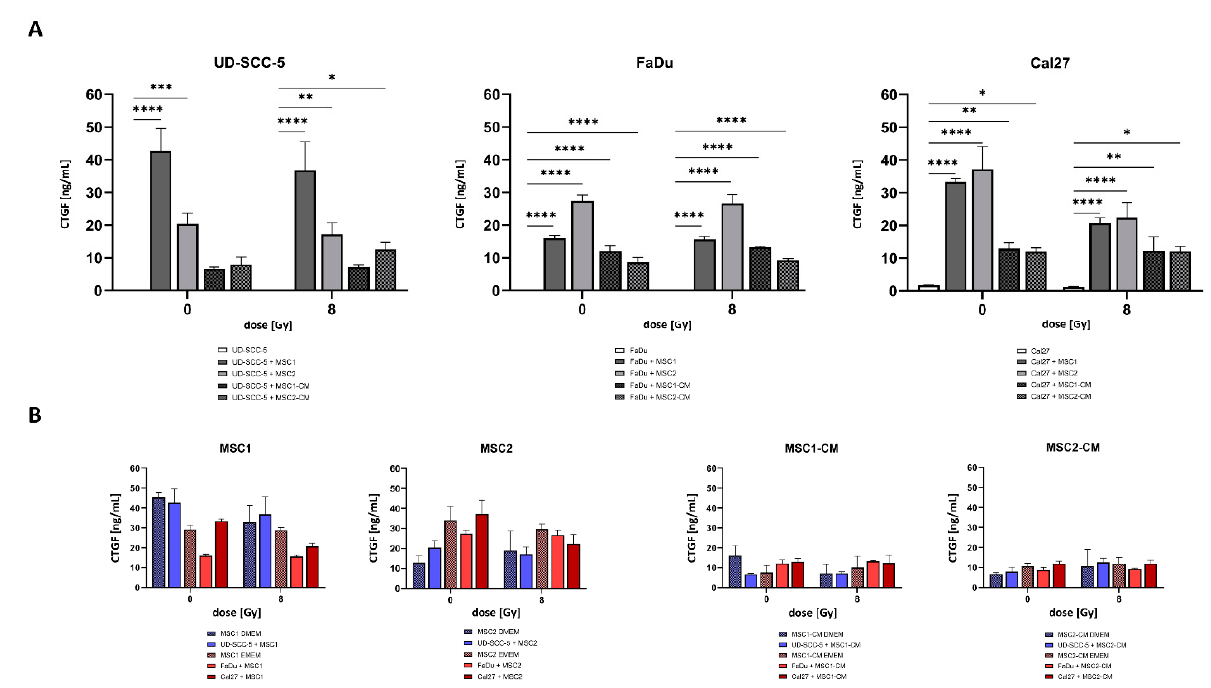
Figure 7. CTGF secretion is increased in HNSCC-MSC co-cultures compared to HNSCC mono-cultures but comparable to MSC mono-cultures. ( A ) CTGF levels after irradiation in HNSCC mono-cultures and HNSCC-MSC co-cultures determined by ELISA measurements. Comparisons between HNSCC mono-culture and HNSCC-MSC co-culture were carried out using one-way ANOVA with post-hoc Dunnett’s tests. ( B ) CTGF levels in MSCs mono-culture and direct HNSCC-MSC co-cultures (left side). CTGF levels in MSC-CM (i.e., without exposure to HNSCCs) and indirect HNSCC-MSC co-cultures (i.e., HNSCCs cultured in MSC-CM) (right side). Here, CTGF levels in MSCs were compared with levels in direct HNSCC-MSC co-cultures (left side), or between MSC-CM and HNSCCs cultured in MSC-CM (right side) by using one-way ANOVA with post-hoc Dunnett’s tests. In order to take the different cell culture media into account, only groups with the same medium were compared (blue and red bars were compared separately). * p < 0.05, ** p < 0.01, *** p < 0.001, **** p < 0.0001.